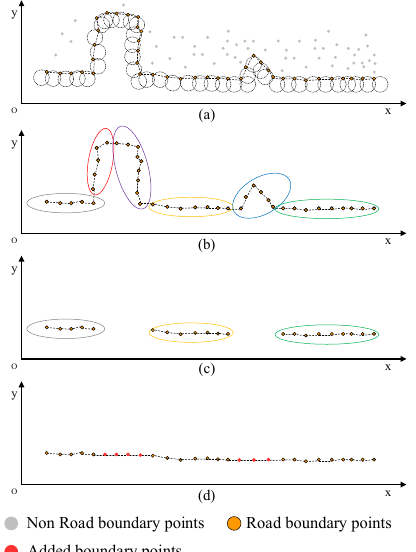
Figure 2. Sketch of Alpha-Smooth method: (a) The application of alpha shapes, (b) Several parts labeled by DBSCAN, (c) Deletion of non-boundary points, (d) Refined road boundary points after smooth curve fitting.